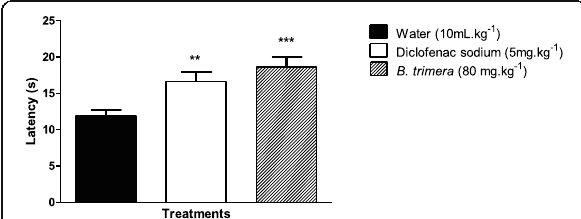
Fig. 4 Antinociceptive effects of the B. trimera aqueous extract in the thermal hyperalgesia test after the chronic inflammation was induced by FCA (i.pl.). Each bar represents the mean ± standard error of 9 mice per group. ** p < 0.01 or *** p < 0.001 represents the level of significance when compared to the water-treated animals (One- Way ANOVA, followed by the Student-Newman-Keuls (SNK) test) Treatment with B. trimera decreases mechanical allodynia after chronic inflammation 48 h after the FCA injection (i.pl), the study observed a significant increase in nociception sensitivity (water: 0.48 ± 0.09 g;